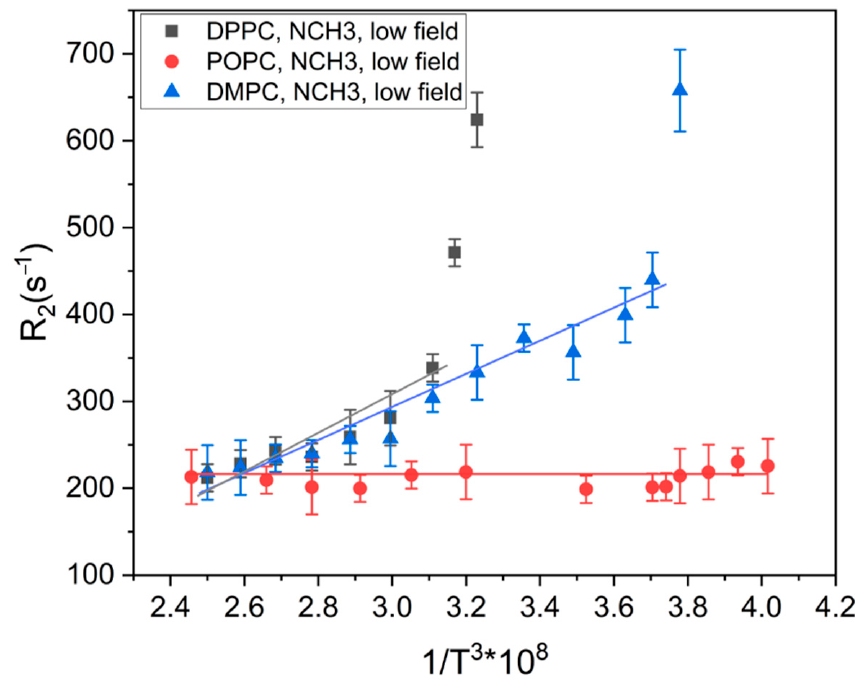
Figure 4. The dependence of the relaxation rate ( R 2 ) of the low-field components of the signal of N + (CH 3 ) 3 groups on the third power of the inverse temperature (1/ T 3 ).